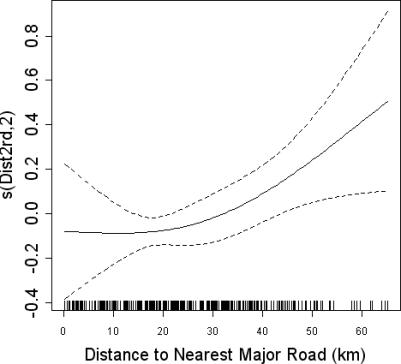
Estimated Conditional Dependence of Elephant Dung-Pile Numbers on Distance to Road (in Kilometres)Estimates (solid line) and confidence intervals (dashed lines), with a rug plot indicating observation density along the bottom of the plot, are shown. To avoid over-fitting, the degrees of freedom were restricted to two for the distance-to-road covariate.